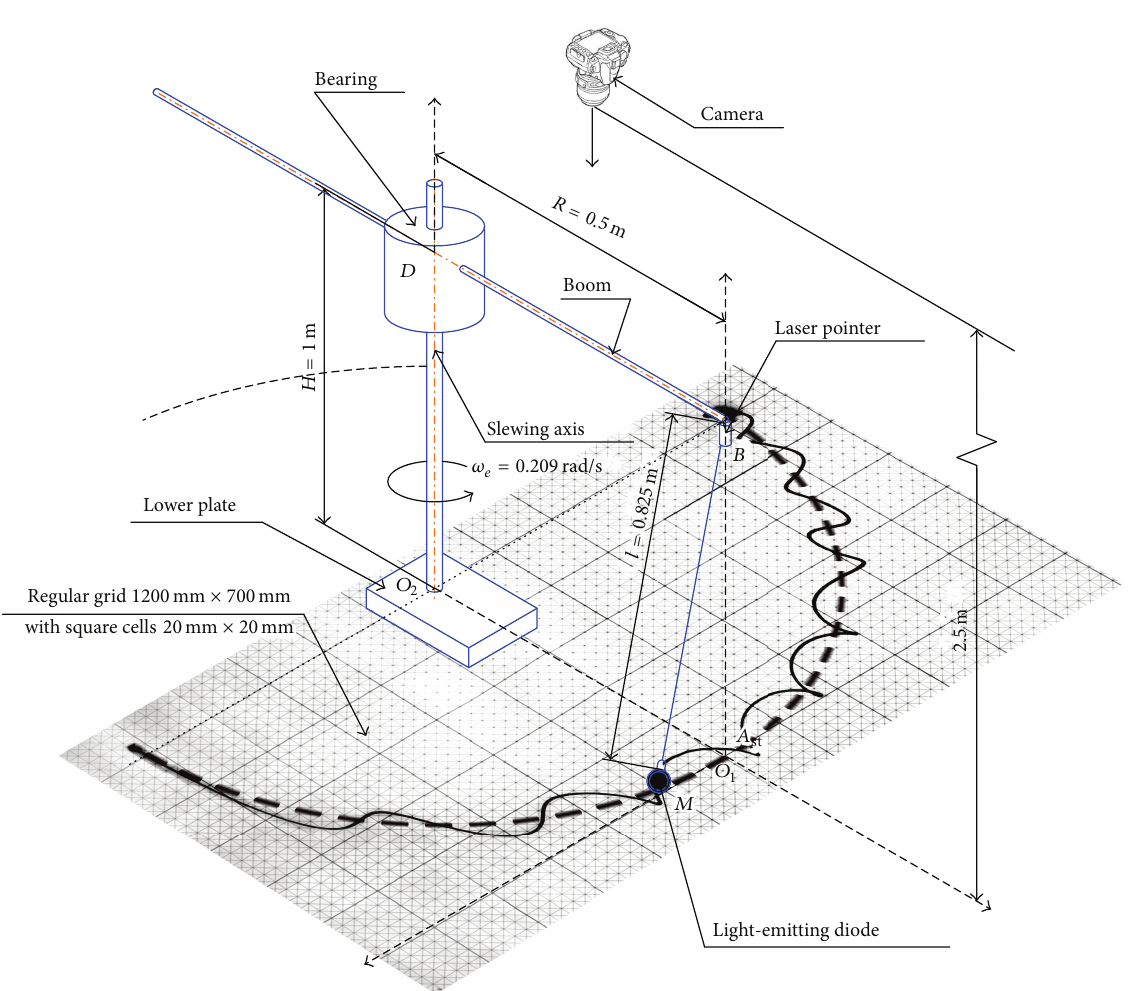
Figure 2: The dimension experimental measurement system for payload 𝑀 swaying motion during crane boom uniform